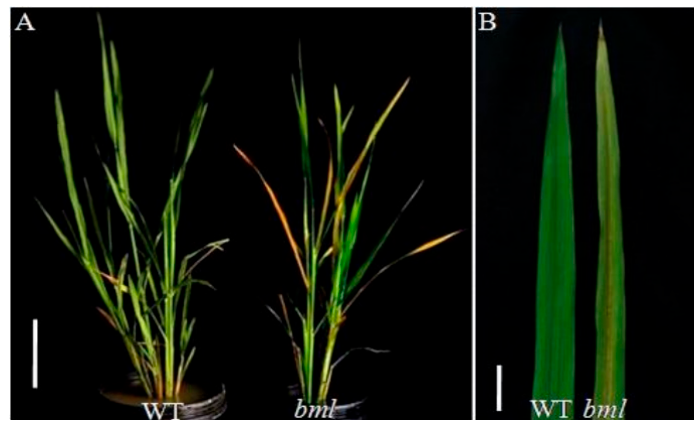
Figure 1. Phenotypes of bml mutant and WT rice plants. ( A ) . Phenotype observed at the heading stage in bml mutant compared to WT. Bar = 10cm. ( B ) . Magnified view of the part of flag leaf from the top of the plant displayed in A. Bar = 5cm.